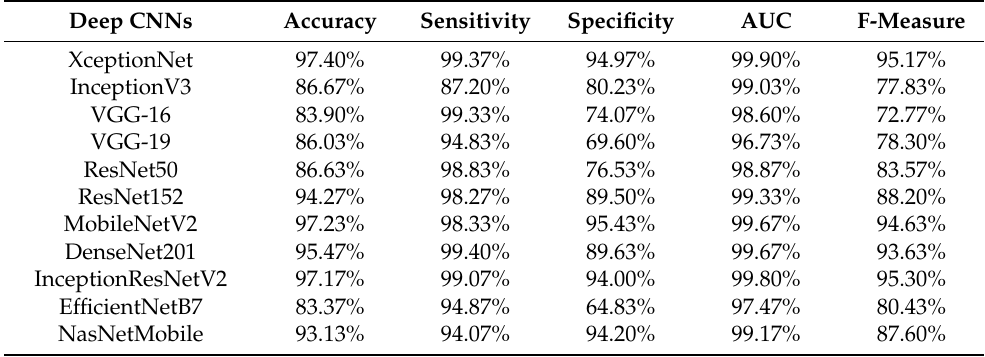
Table 4. Classification results of normal, pneumonia, and COVID-19 using the cropped lungs and 11 CNNs (Approach 0: Unbalanced dataset).